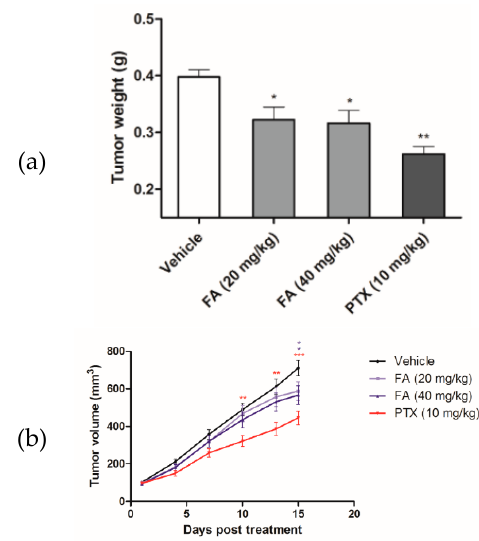
Figure 9. The antitumor effect of FA was assessed in terms of ( a ) weight of excised tumors (* p < 0.05 and ** p < 0.01 when compared to the vehicle group), and ( b ) volume of the growing subcutaneous tumors (* p < 0.05, ** p < 0.01, and *** p < 0.001 when compared to the vehicle group).